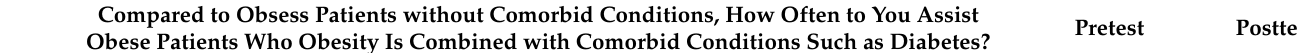
Table 5. Questionnaire Item 15 Response Frequency *.